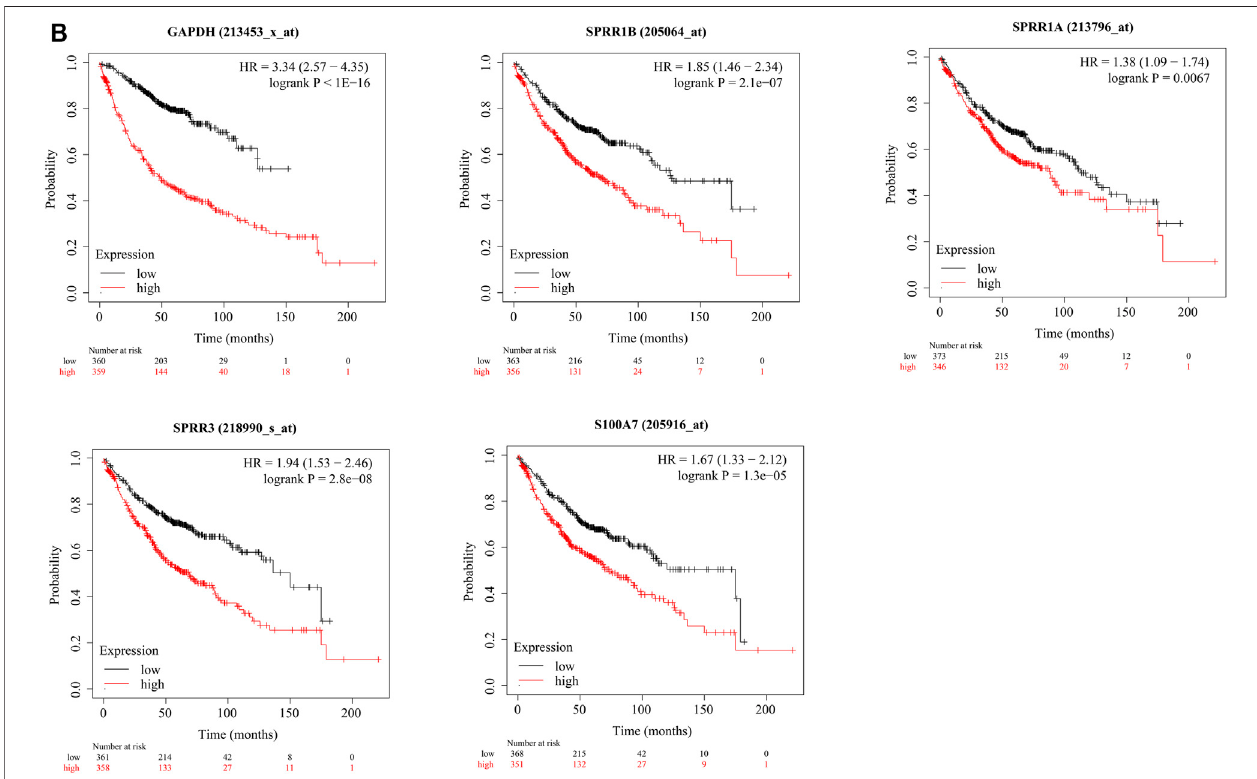
Table S6 . In total, 86 genes, including 29 hypomethylation miRNA-targeting upregulated genes and 57 hypermethylation miRNA-targeting downregulated genes (11 hypomethylated miRNA-targeting upregulated genes and 26 hypermethylated miRNA-targeting downregulated genes without